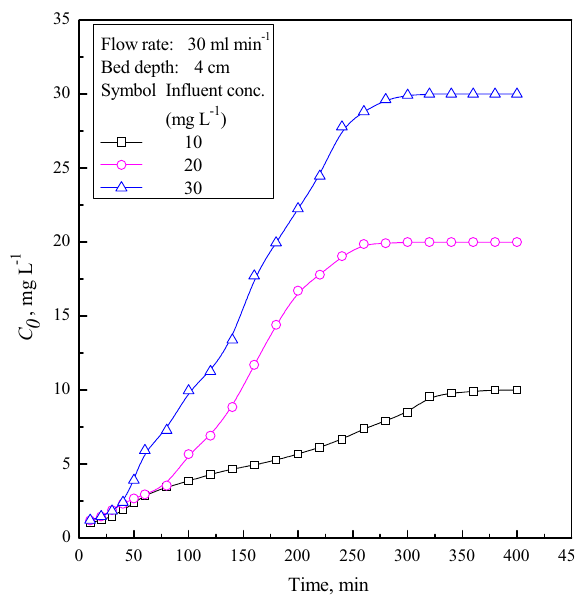
Fig. 6 Effect of influent metal ion concentration for Cr(VI) ion adsorption